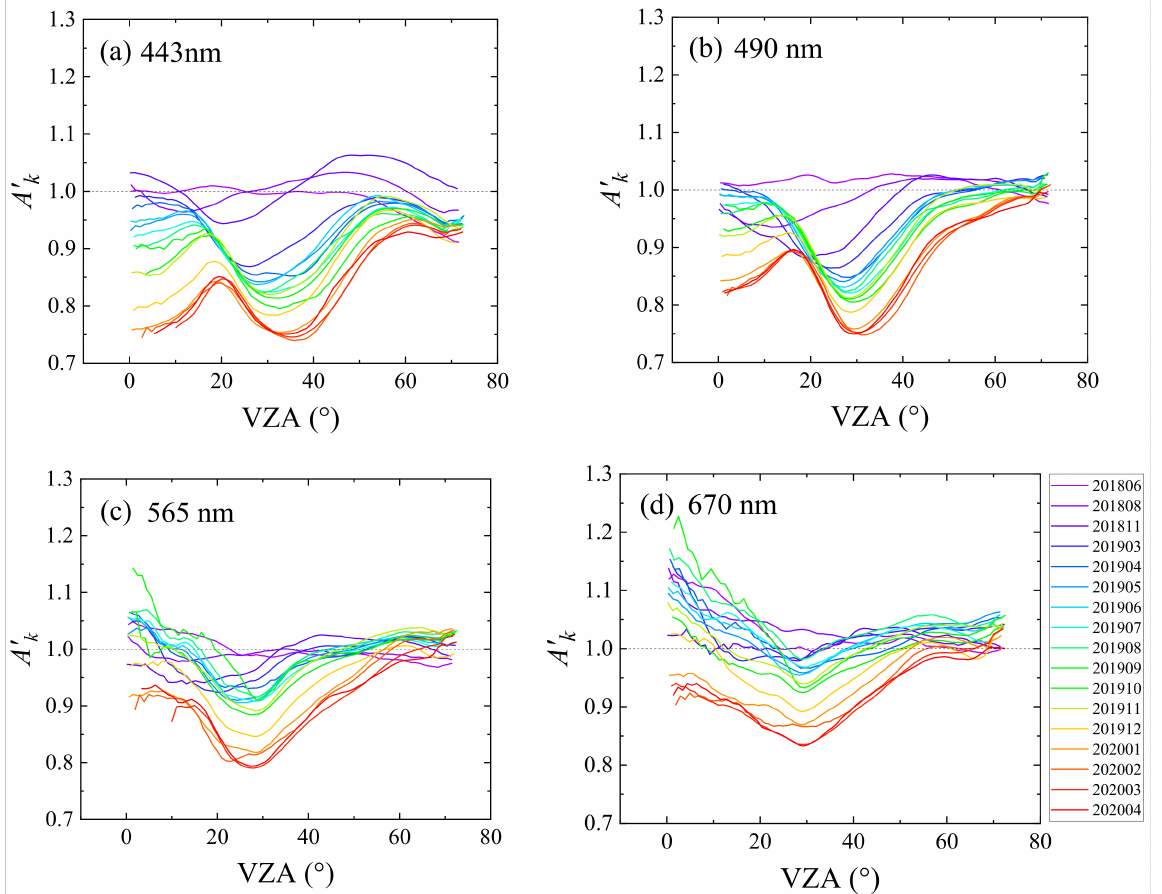
Figure 5. The monthly average A (cid:48) from March 2019 to April 2020 for ( a ) 443 nm, ( b ) 490 nm, ( c ) 565 nm and ( d ) 670 nm bands of